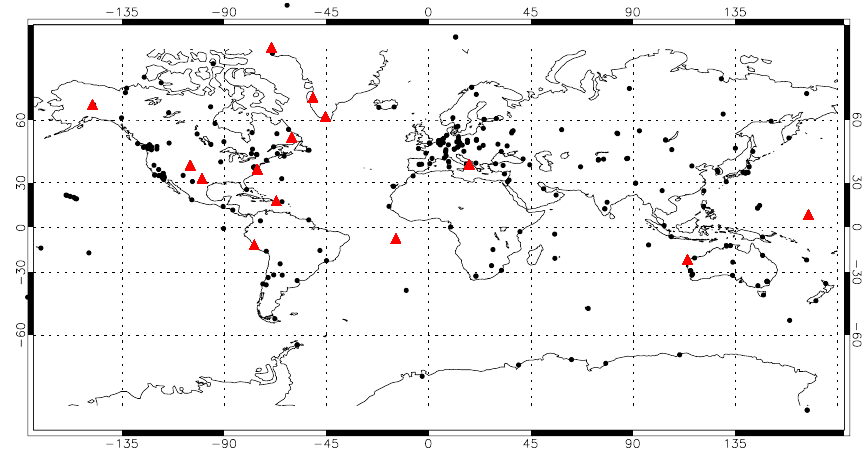
Fig. 1. Map showing locations of IGS stations (dots) and vertical ionosondes (triangles).